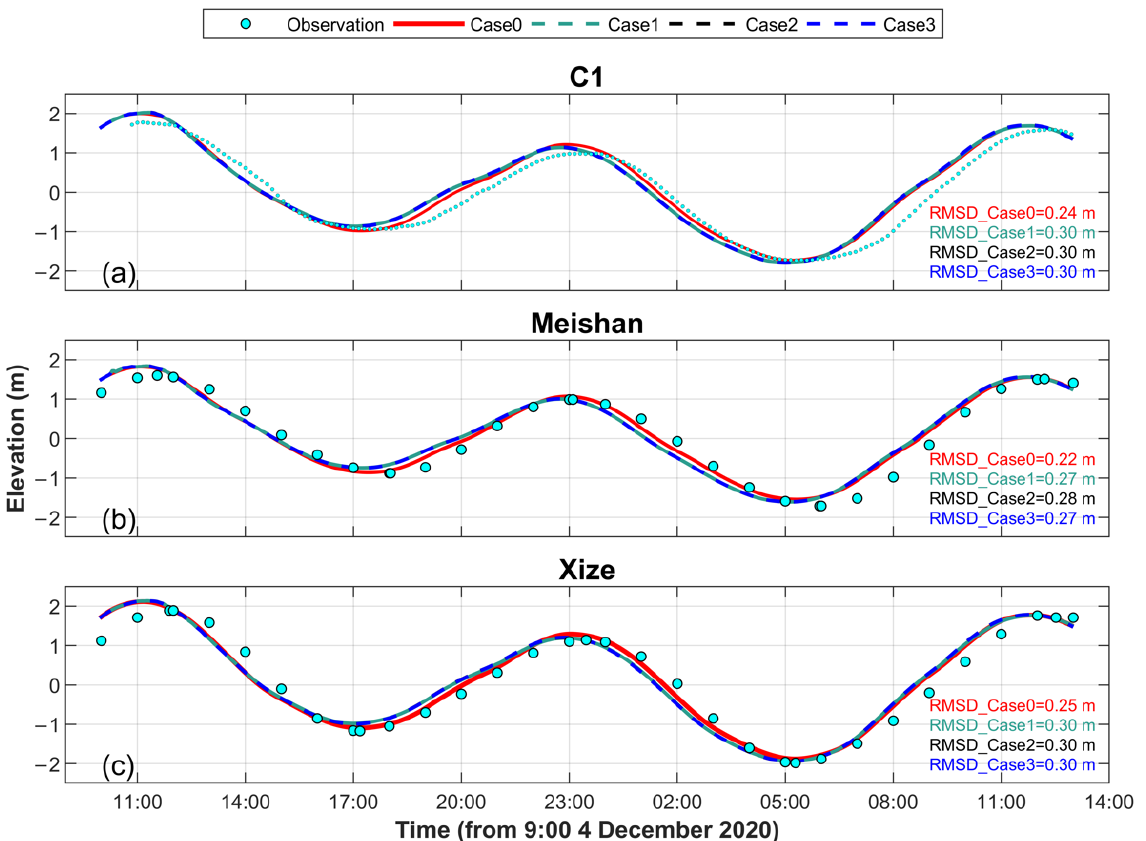
Figure 4. Verification of elevation at stations ( a ) C1, ( b ) Meishan, and ( c ) Xize.